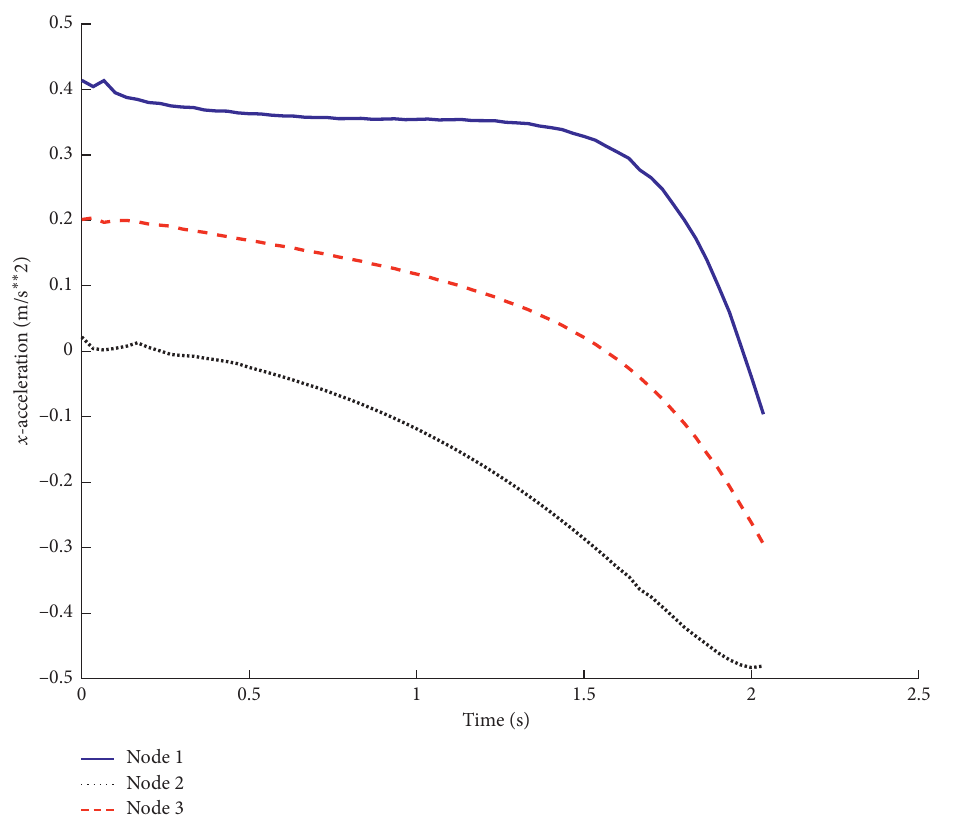
Figure 7: Curves of x -acceleration over time for some nodes in the deployable